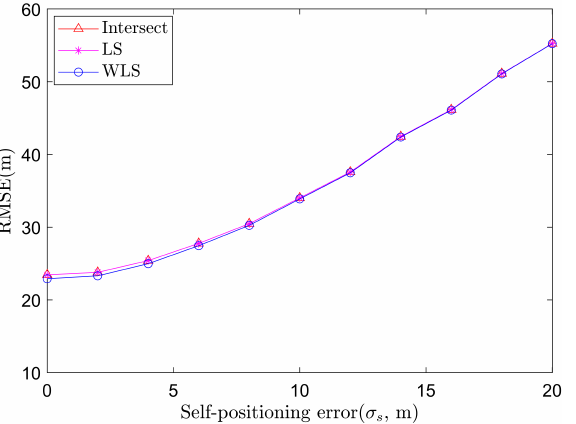
Figure 2. Average RMSE of target localization algorithms based on angle measurements of two sensors at a fixed angle measurement error.